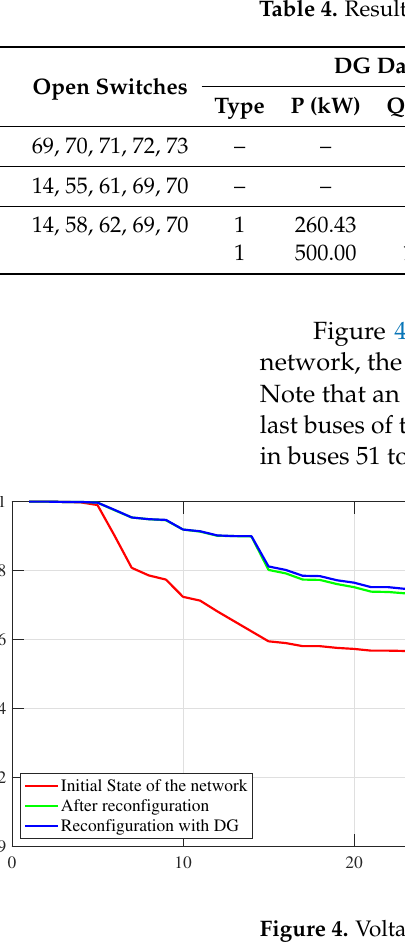
Table 4. Results for the 69-bus test system.